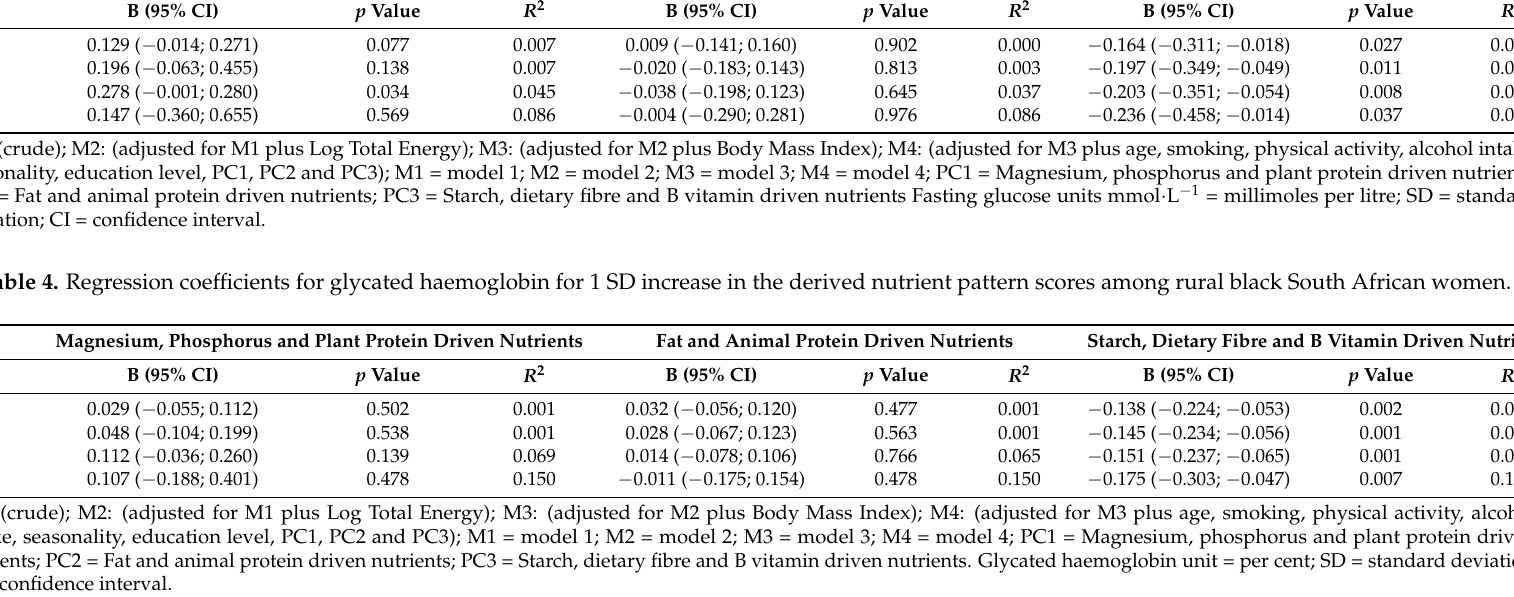
Table 3. Regression coefficients for fasting glucose for 1 SD increase in the derived nutrient pattern scores among rural black South African women. Magnesium, Phosphorus and Plant Protein Driven Nutrients Fat and Animal Protein Driven Nutrients Starch, Dietary Fibre and B Vitamin Driven Nutrients